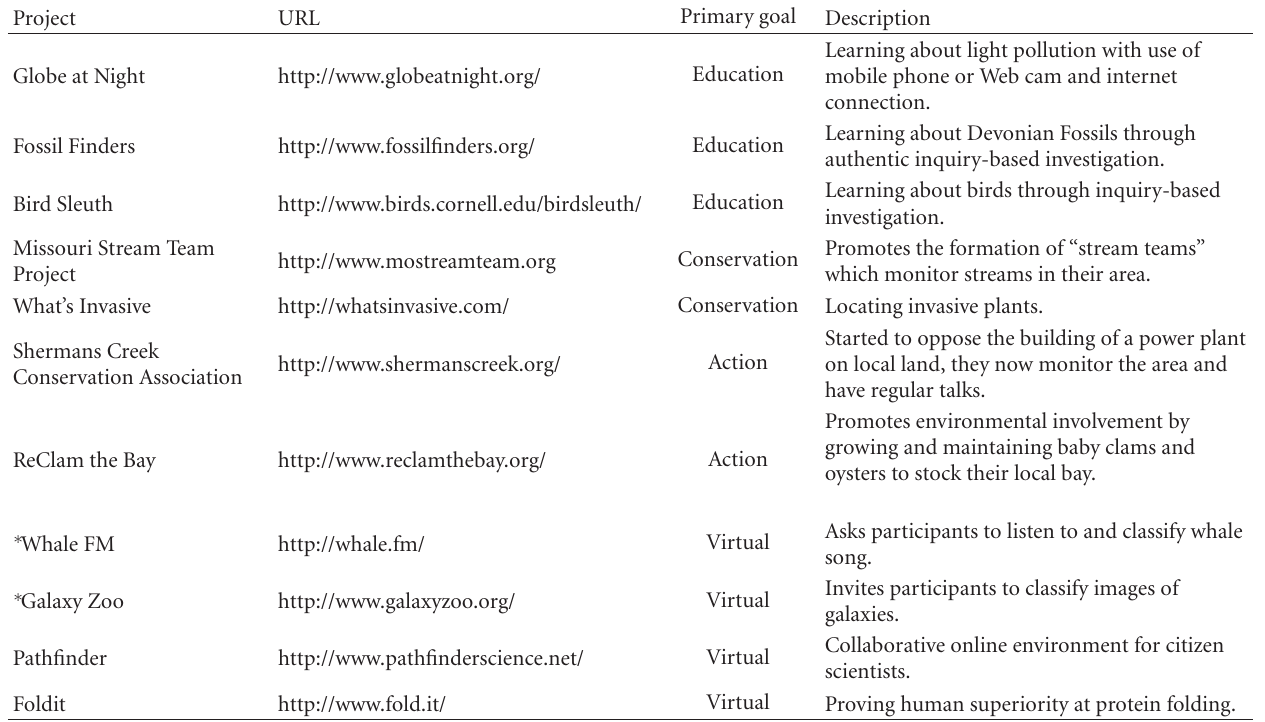
Table 2: Primary goals of citizen science projects (adapted and modified from Wiggins and Crowston